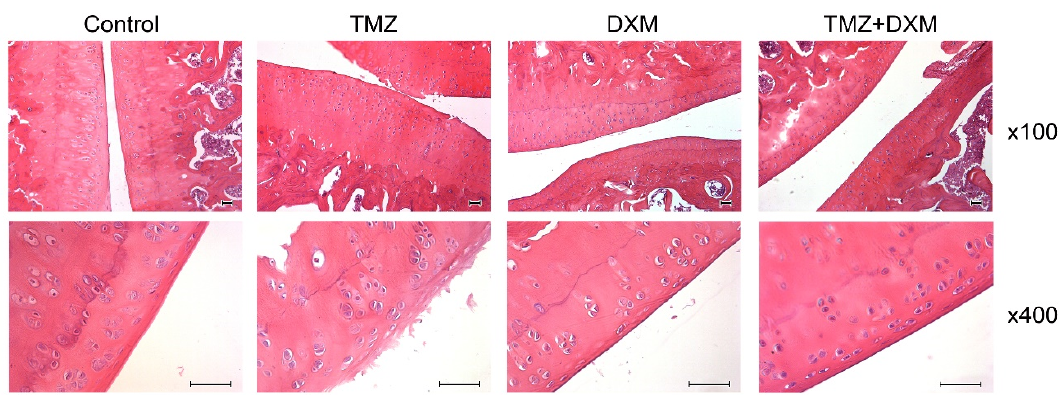
Figure 3. Histological analysis of the knee joint, fragments of the femoral and tibial epiphysis, and femur epiphyseal cartilage in the control, TMZ, DXM, and TMZ + DXM rat groups. Hematoxylin and eosin (H&E) staining. Magnification × 100, × 400. Scale bars 50 µ m. TMZ – temozolomide, DXM – dexamethasone.